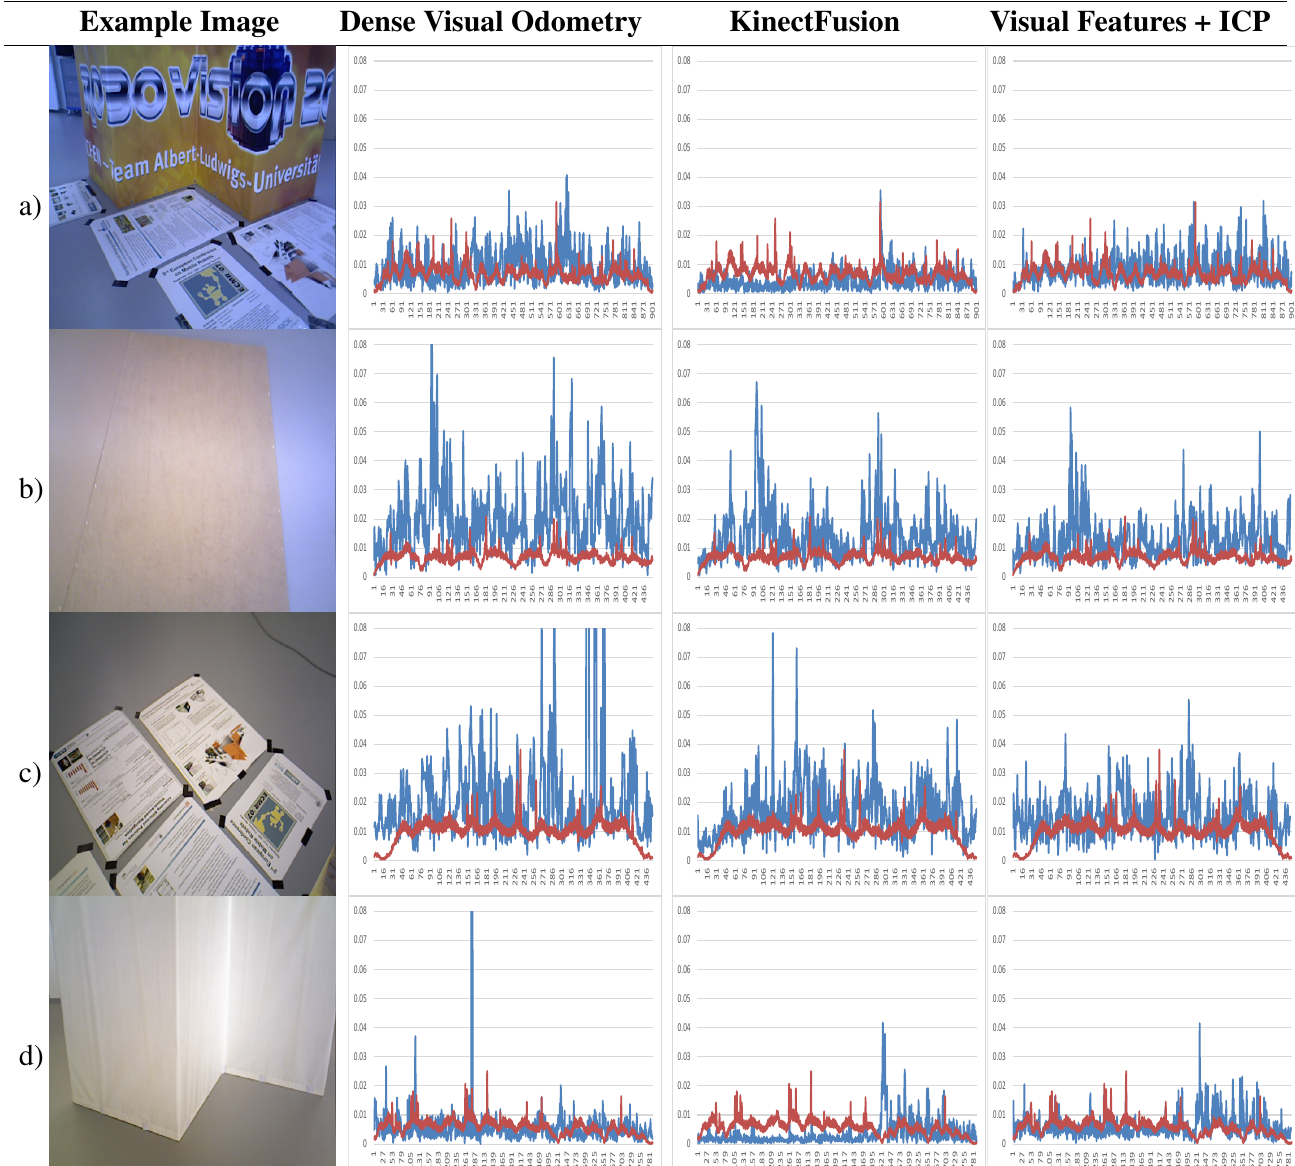
Table 2. Relative pose translational errors in blue color (y-axis, meters) on the fr3 datasets (x-axis, frames) of the dense visual odometry, KinectFusion and visual features with ICP refinement methods. Red color values represent the ground-truth pose movement. Images belong to the dataset; ( a ) structure and texture. ( b ) no structure and no texture. ( c ) no structure and texture. ( d ) structure and no